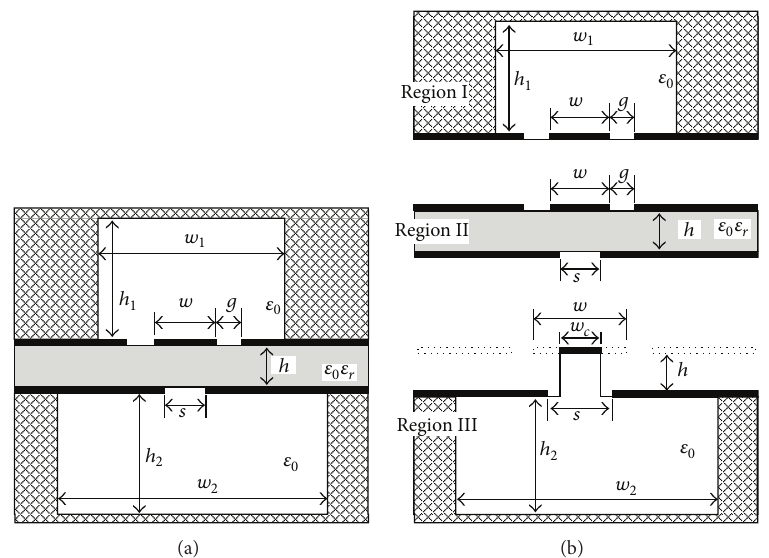
Figure 5: Configuration of the transitional structure: (a) the entire structure and (b) individual structures used in the analysis.